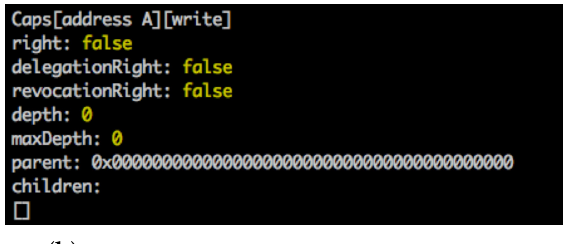
Figure 6. Token Creation by the Owner Entity addressA .